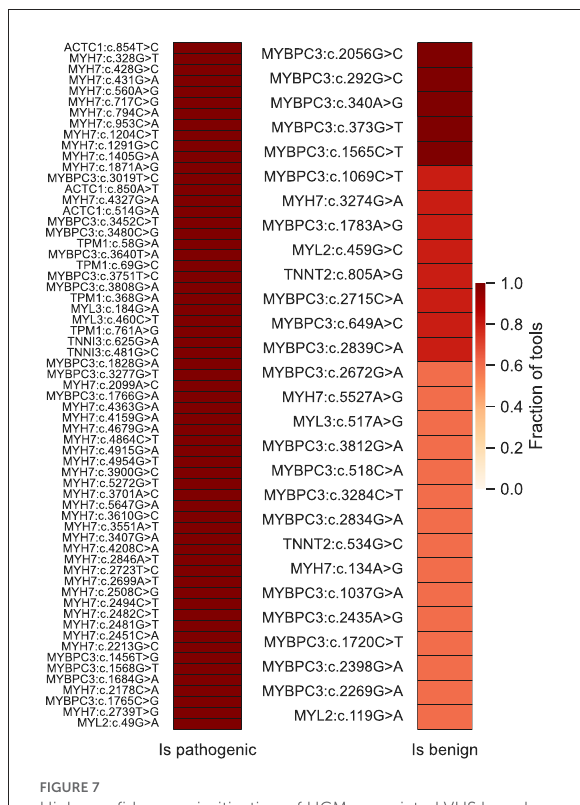
FIGURE7 High-confidence prioritization of HCM-associated VUS based on predictions of the 5 top-performant tools (ClinPred, MISTIC, FATHMM, MPC and MetaLR). On the left, 63 variants for which 100% of the tools predict pathogenicity. On the right, variants predicted to be benign by more than 50% of the